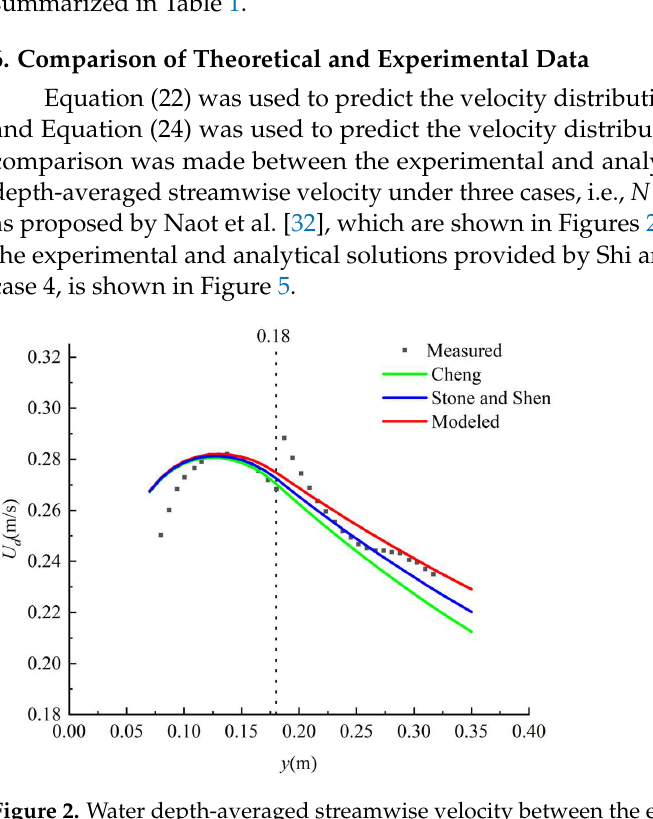
Figure 4. Water depth-averaged streamwise velocity between the experimental data and analytical solution in case 3. φ 1 = 0.3044, φ 2 = 0.6107, and φ 3 = 0.4318.